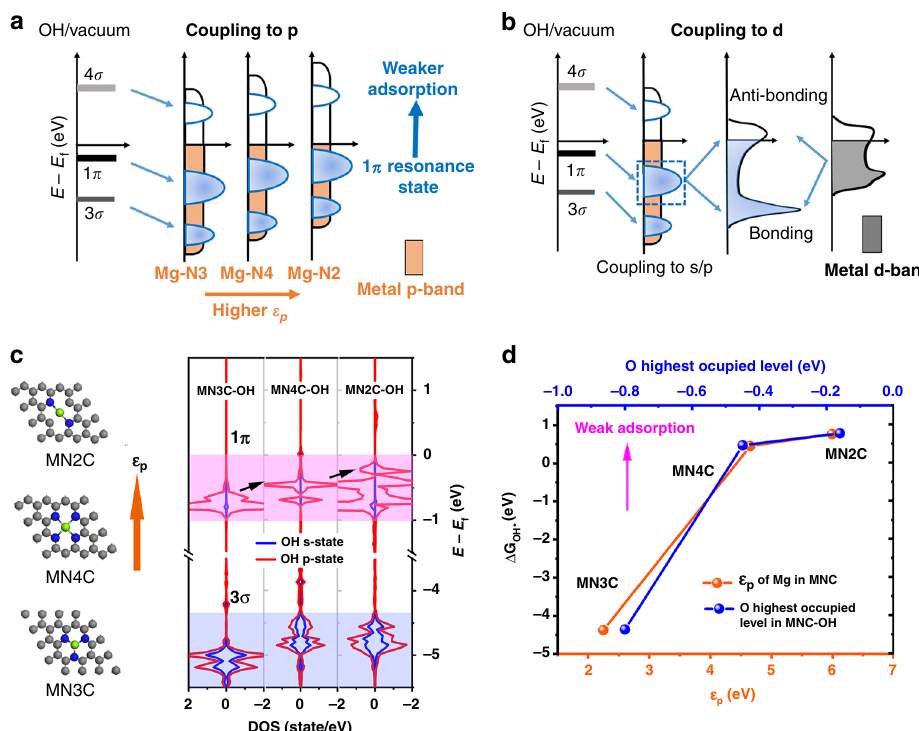
Fig. 2 OH* Adsorption-energy-based activity descriptors for p-band Mg cofactors. a , b Schematic illustration of the change in local electronic structure at OH molecular orbitals upon adsorption on the surface of p-band metal or d-band metal. c The Mg cofactors ’ geometries in different N-coordinated environments which tune ε p of Mg atoms, and the corresponding density of states changes of OH after interaction with p-state of Mg. d Adsorption free energies of OH as a function of the ε p position of metal atoms for Mg cofactors, and also as a function of highest O occupied state of hydroxyl after interaction. Lines are used to fi t the linear